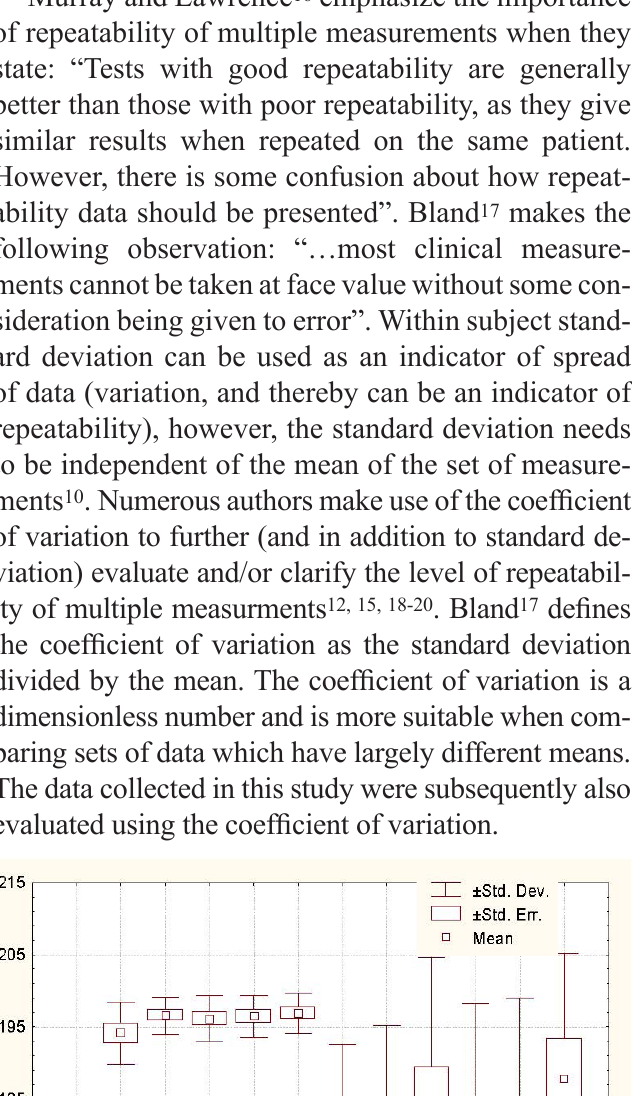
Figure 3: A box and whisker plot (of B in milliseconds) for each subject is shown.